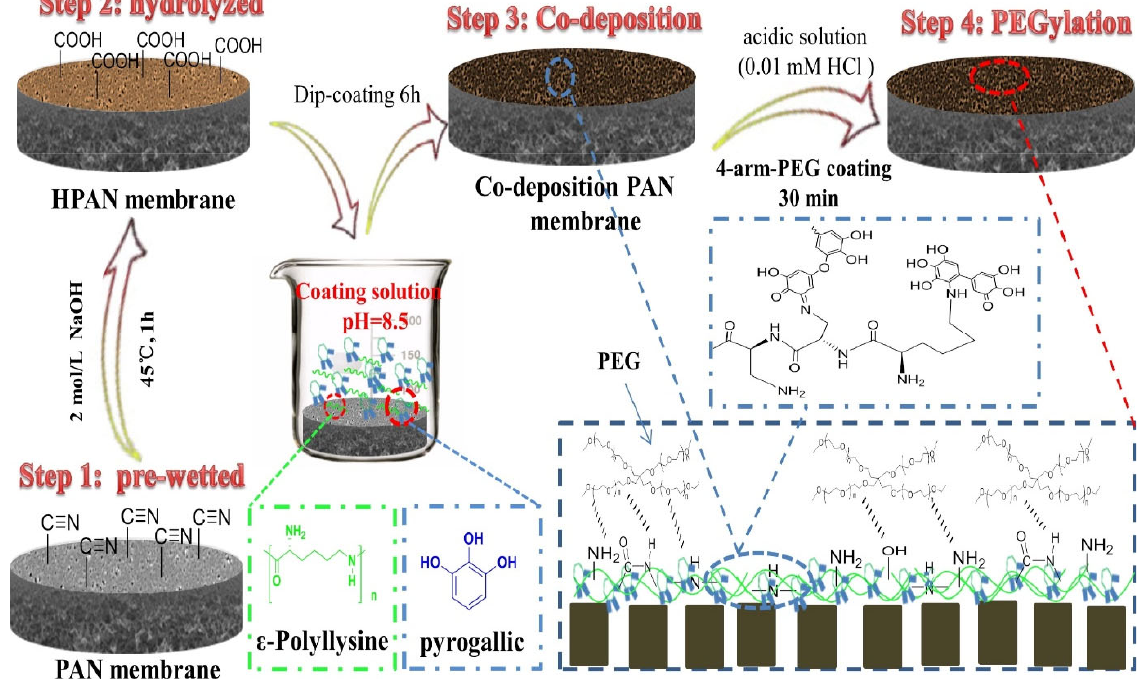
Figure 7. Preparation of a loose NF membrane involving ε -Poly-L-lysine and pyrogallic co-deposition and PEGlation steps [102] (Copyright 2018. Reproduced with permission from Elsevier.)